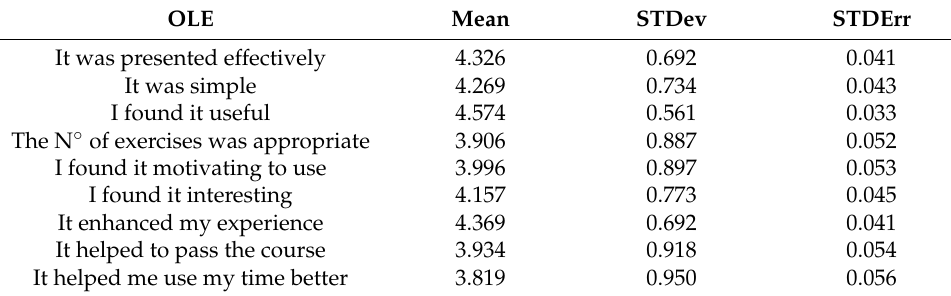
Table 8. Questions and results of the ole satisfaction